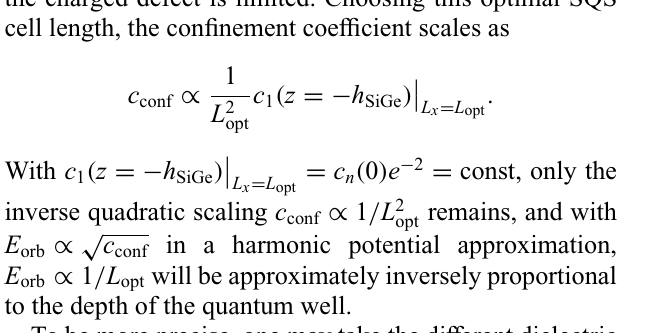
and the red opt